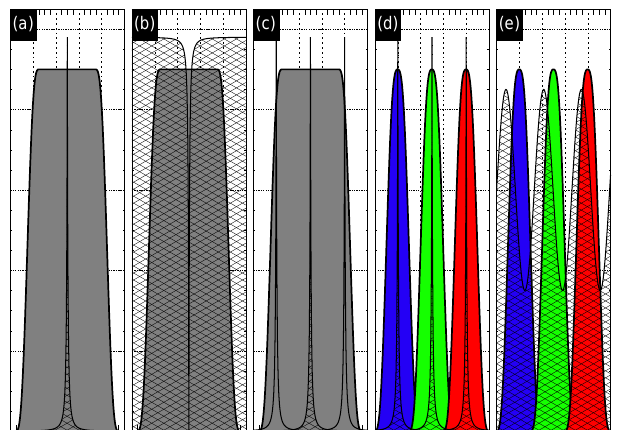
Figure 17. (a) Broadband CCD and narrowband transmission filter, (b) broadband CCD and narrowband rejection (notch) filter, (c) broad- band CCD and three different narrow passband transmission filters, (d) three-channel wide-band color CCD and a single transmission filter with three narrow passbands, (d) three-channel wide-band color CCD and a single modulated transmission